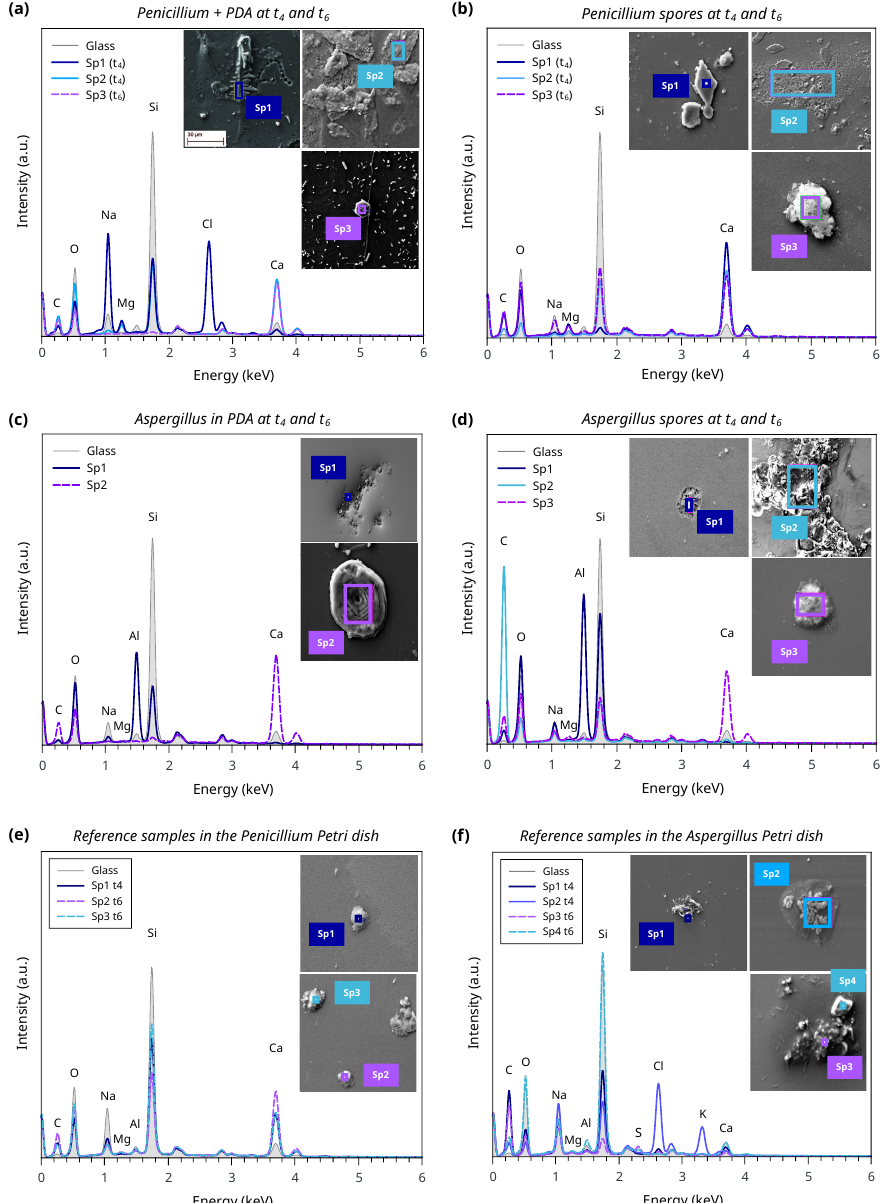
Figure 4. SEM-EDS spectra of crystals and surface alterations of the SPB-87 glass samples (analysis spots marked in the SEM images presented), inoculated with ( a ) Penicillium chrysogenum (PS1) in PDA or ( b ) PS1 spores in Tween; ( c ) Aspergillus niger (AS1) in PDA or ( d ) spores in Tween; ( e ) reference samples in the PS1 and ( f ) AS1 environments at t 4 and t 4